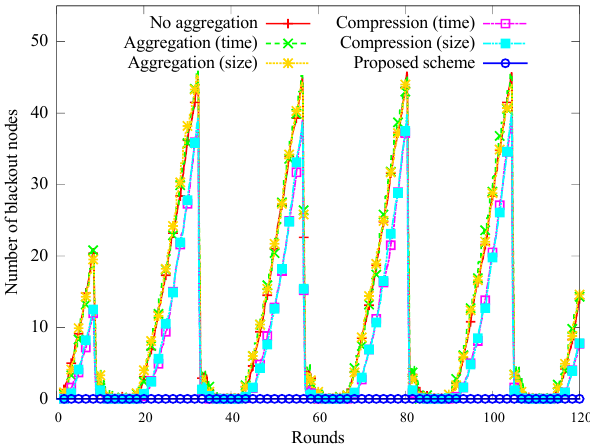
Figure 5. Change in the number of black-out